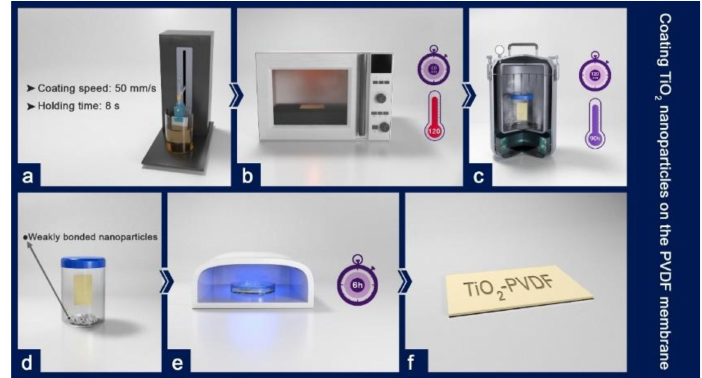
Figure 2. Coating TiO 2 nanoparticles on the PVDF membrane: ( a ) dip-coating the membrane in the TiO 2 sol-gel solution (coating speed: 50 mm / s; holding time: 8 s); ( b ) drying the membrane at 120 ◦ C for an hour; ( c ) treating the membrane using the hydrothermal method at a low temperature (90 ◦ C) for two hours; ( d ) the separation of the weakly bonded nanoparticles after heat treatment; ( e ) exposing the membrane to UV light for six hours; ( f ) the TiO 2 –PVDF